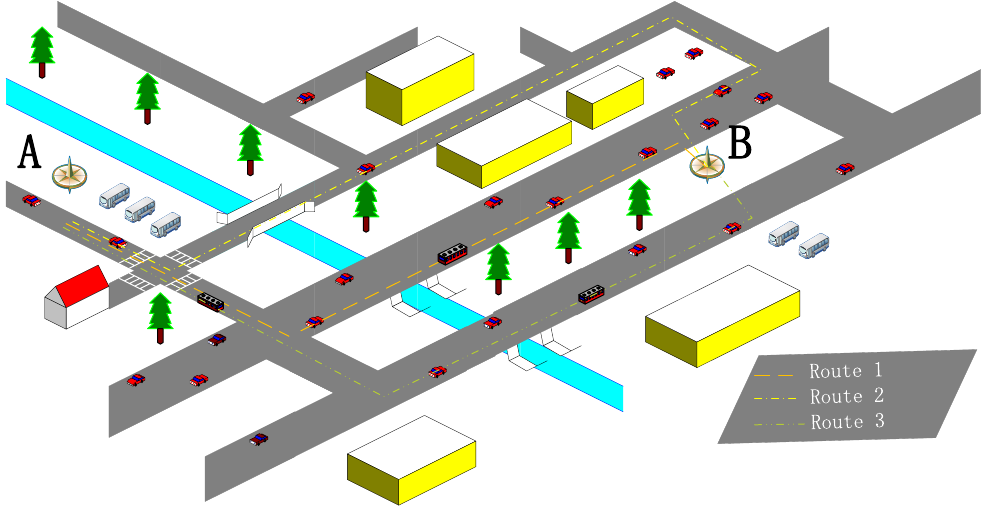
Figure 15. Example of route planning for a traffic system using traffic flow model and vehicle stability criterion.